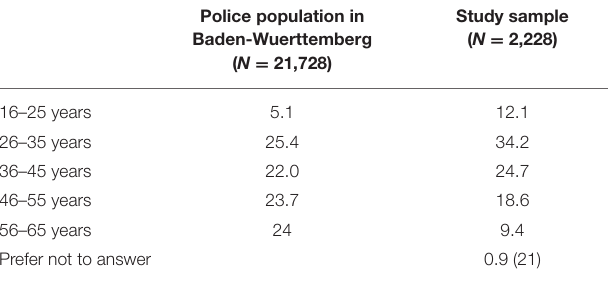
TABLE 2 | Age groups in police population in Baden-Wuerttemberg and study sample